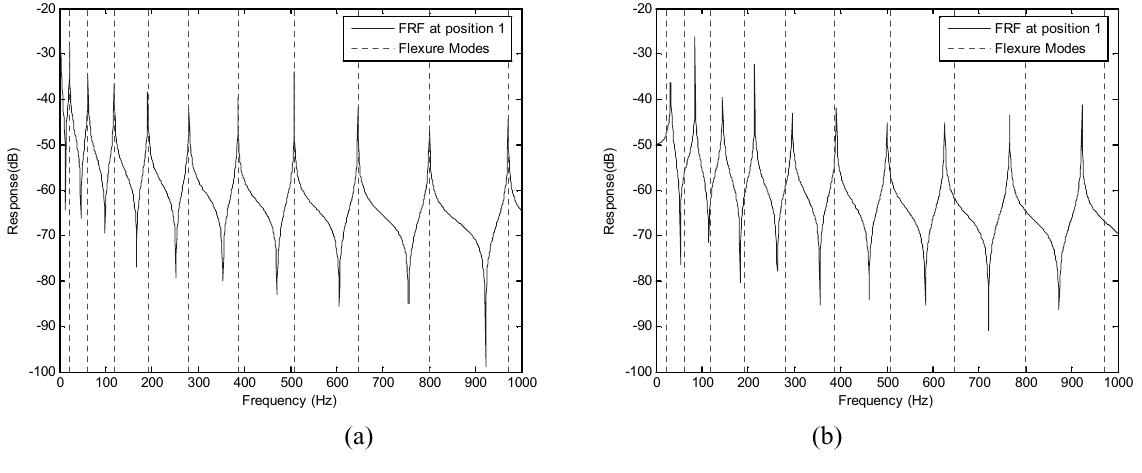
Fig. 3. Circular ring with 2 elements and P int = 0 (a), P int = 3 bar